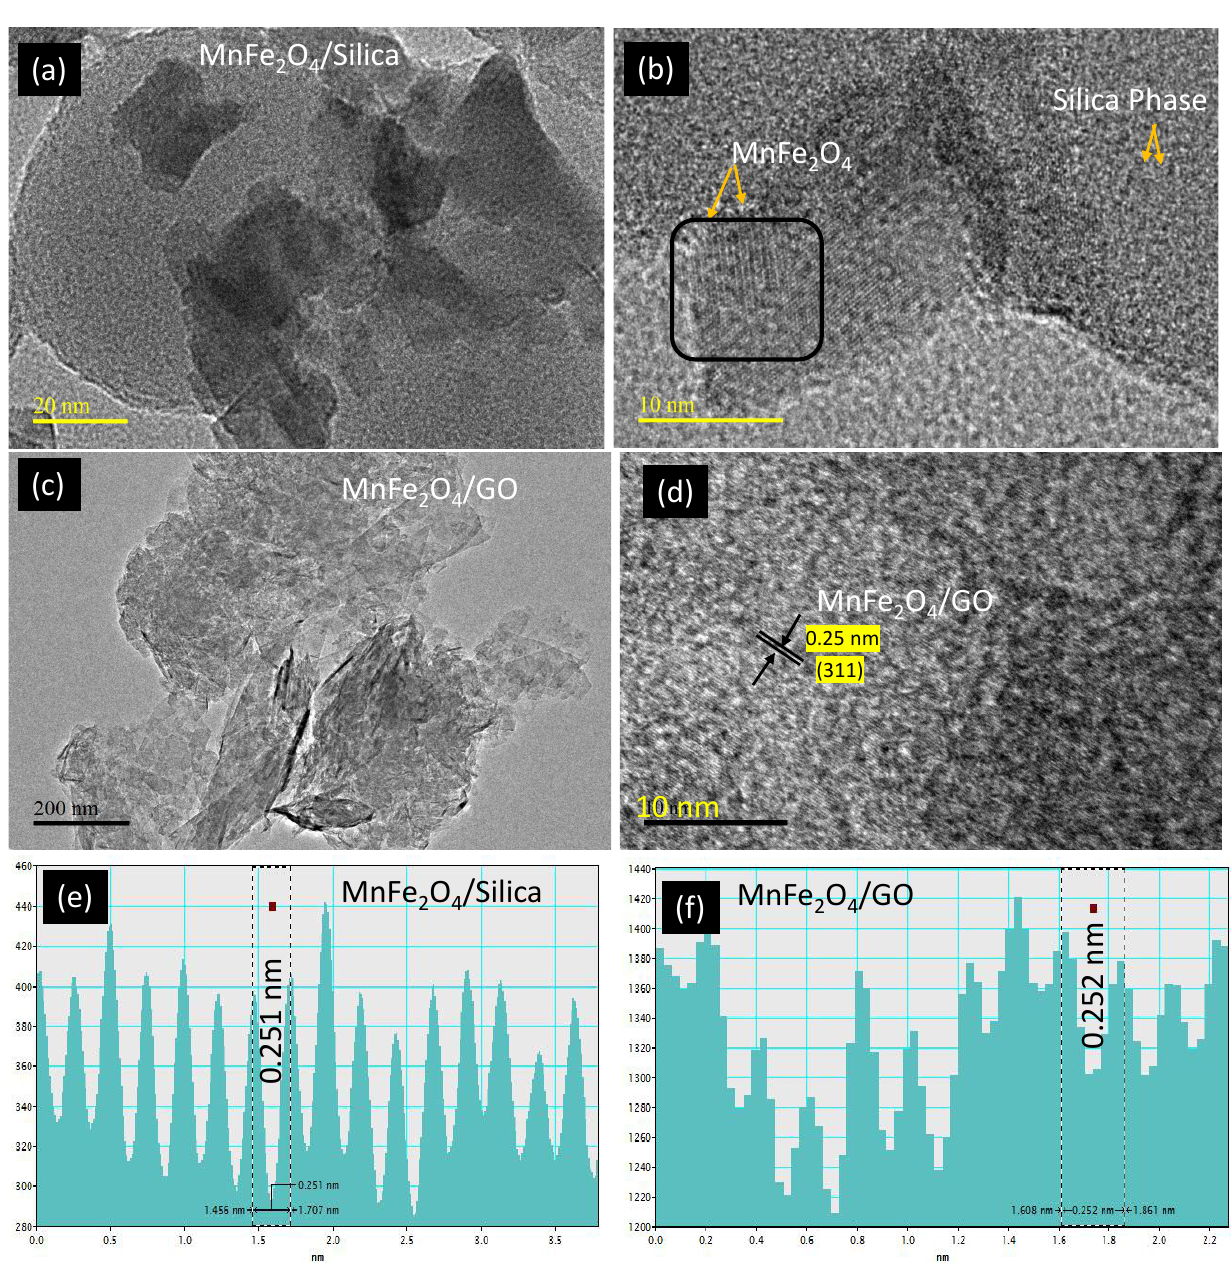
Figure 2. TEM analysis of ( a , b ) MnFe 2 O 4 /silica; and ( c , d ) MnFe 2 O 4 /GO at different scale magnifica- tions with corresponding lattice fridges ( e , f ).